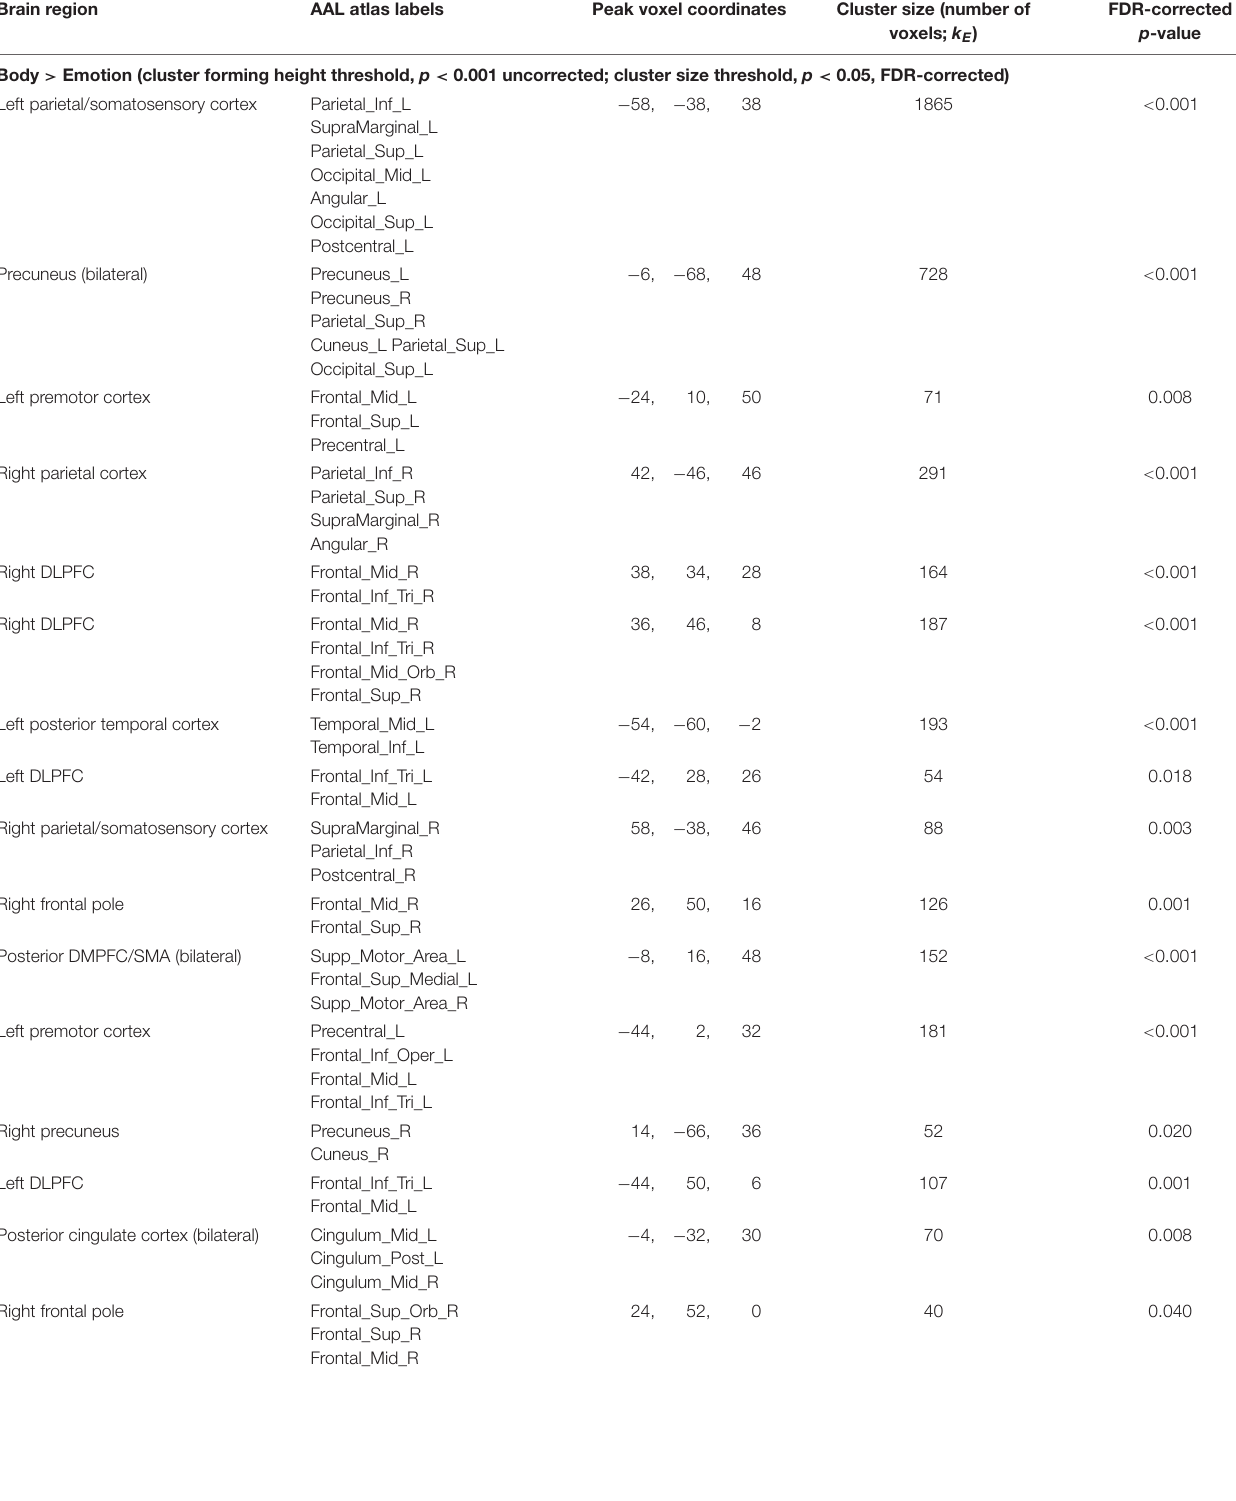
TABLE 1 | fMRI results: body vs. emotion. Brain region AAL atlas labels Peak voxel coordinates Cluster size (number of